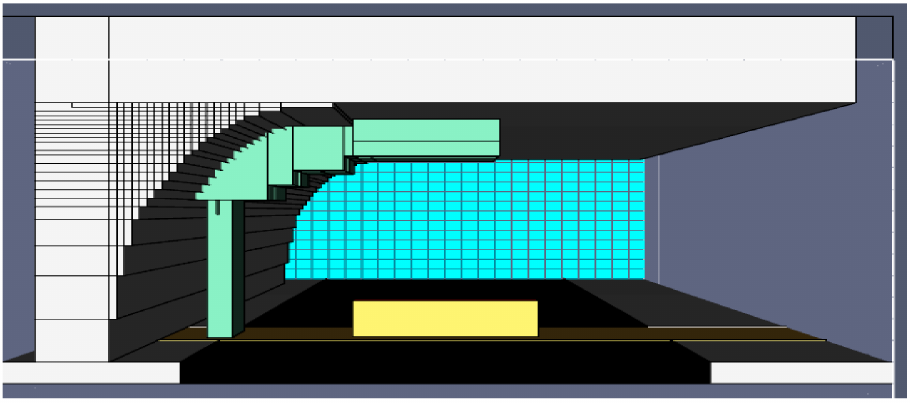
Figure 2. Step-rectangular meshes used to model tunnel ceiling